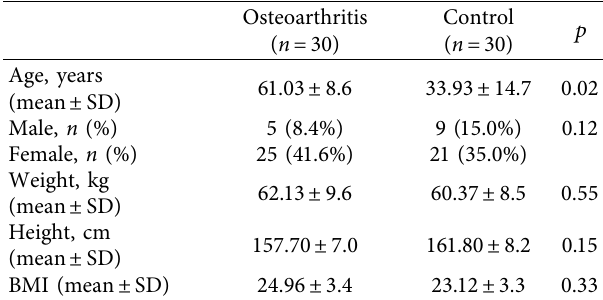
Table 1: Demographic data between osteoarthritis and control